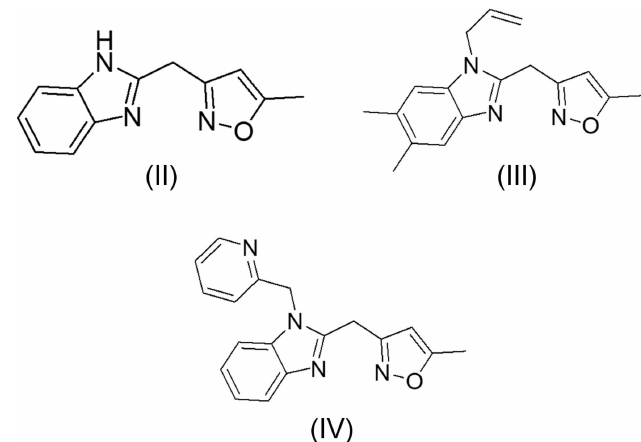
Figure 6 The energy band gap of 6-methyl-2-[(5-methylisoxazol-3-yl)methyl]-1 H -